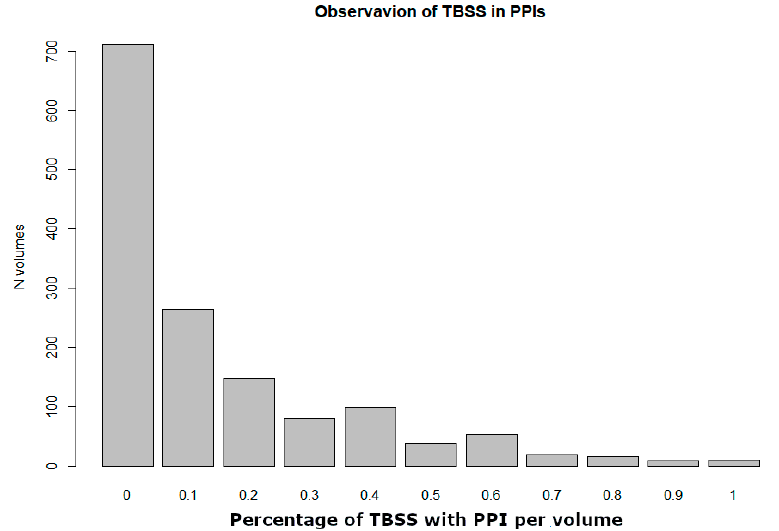
Figure 9. Percentage of PPIs per volume with a TBSS signature .